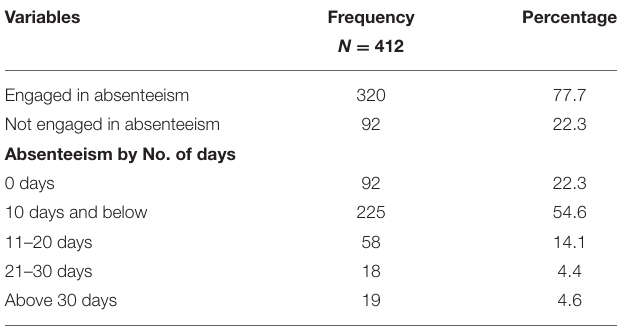
TABLE 1 | Socioeconomic and demographic characteristics of respondents. TABLE 2 | Levels of